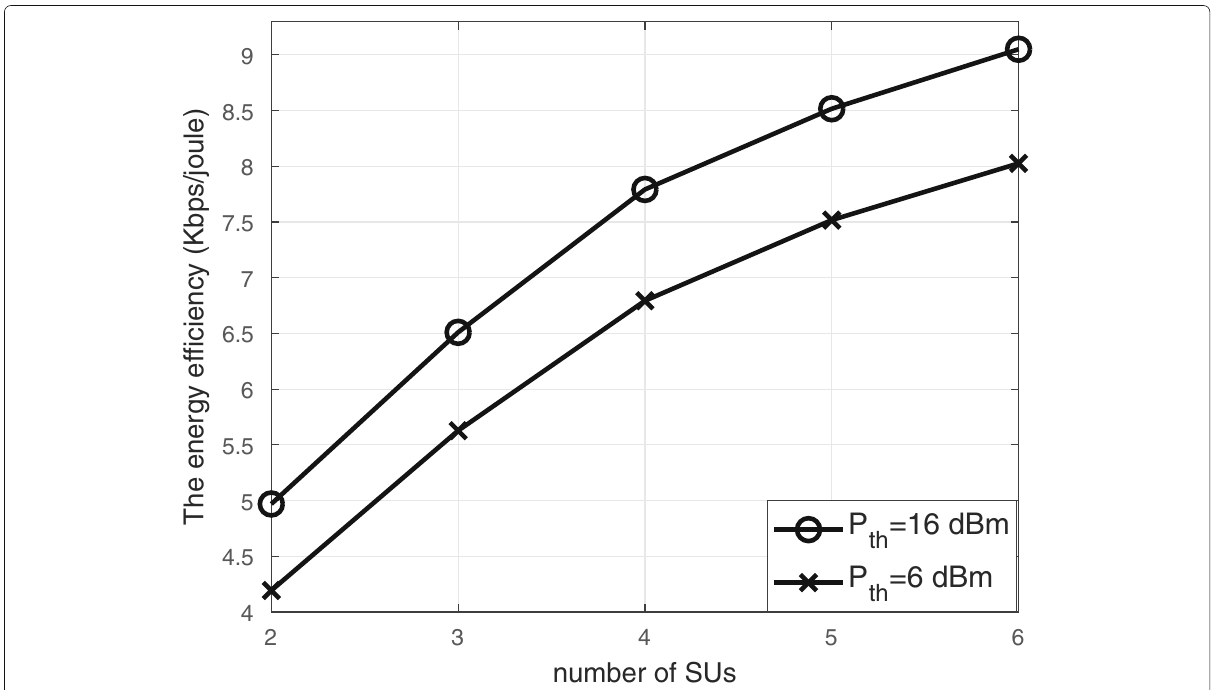
Fig. 11 Energy efficiency versus number of SUs. The performance of the proposed algorithm with different number of SUs per cell